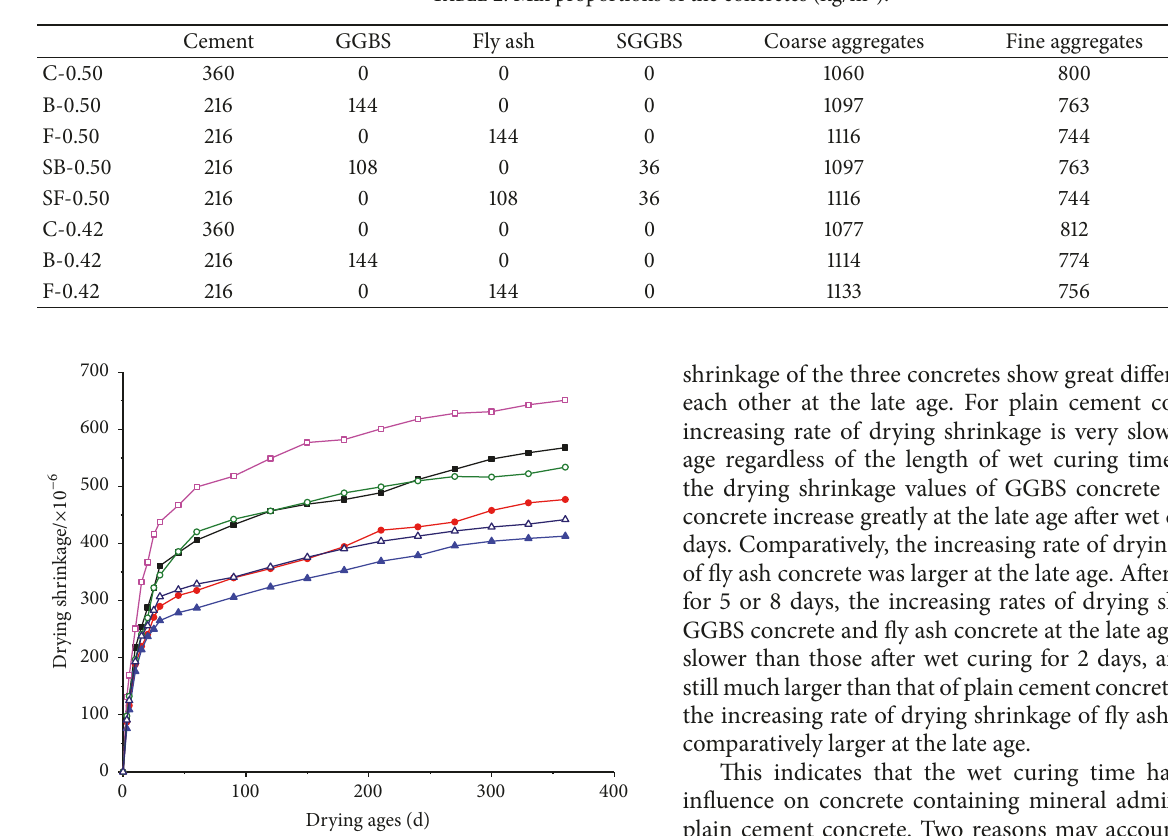
Table 2: Mix proportions of the concretes (kg/m 3 ).